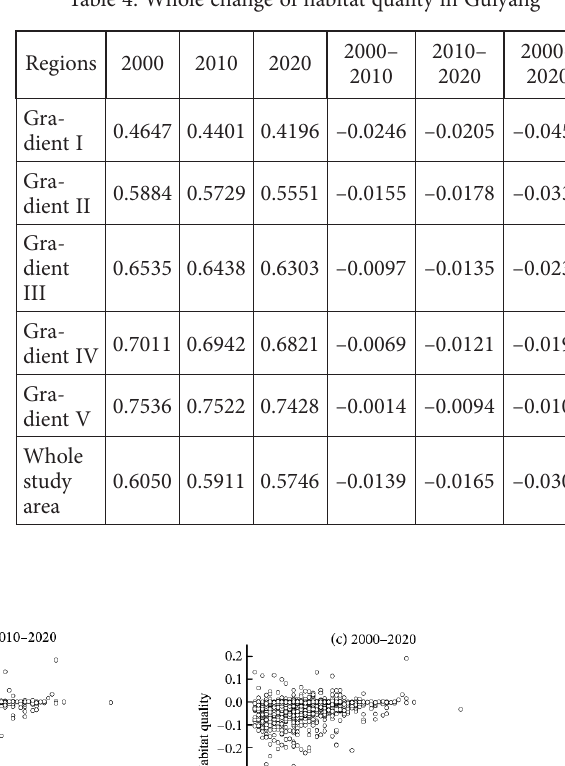
Table 4. Whole change of habitat quality in Guiyang